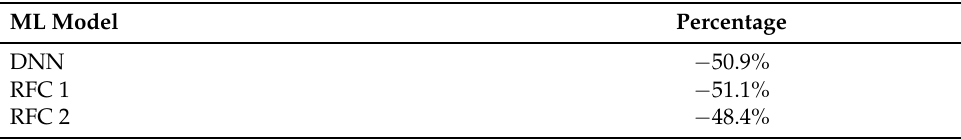
Table 5. Execution